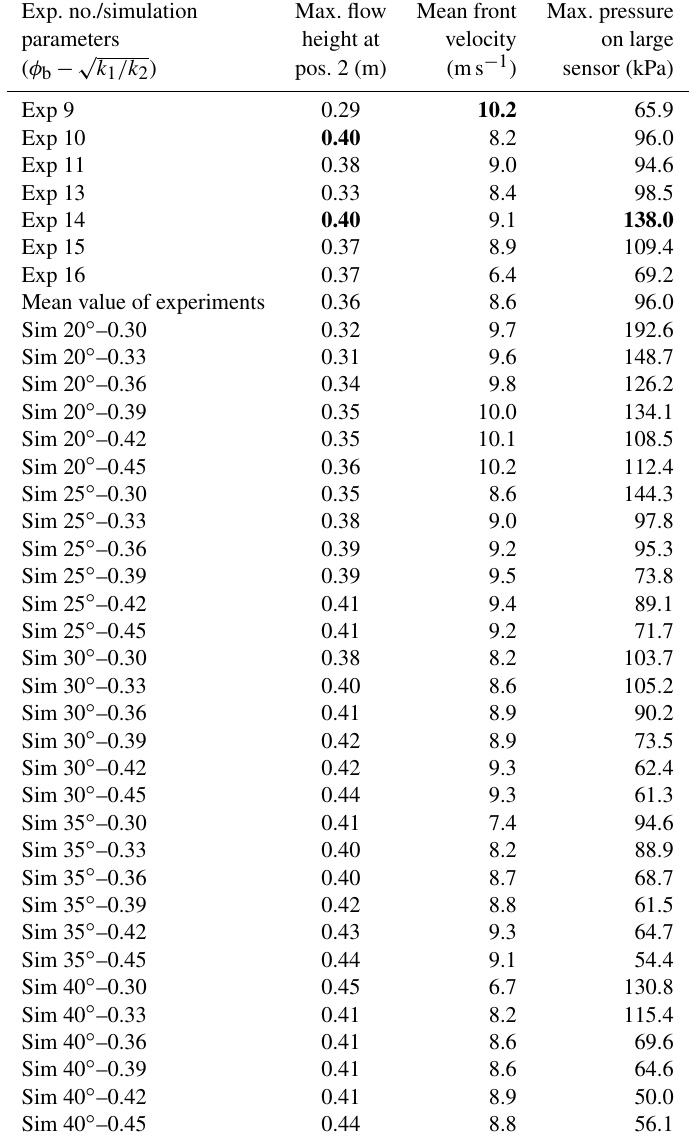
Table B1. Values of the maximum flow height at position 2, the mean front velocity and the maximum applied pressure for all selected experiments and simulations. Bold text shows the maximum values of the height, the velocity and the pressure of all selected experiments. Exp. no./simulation Max.